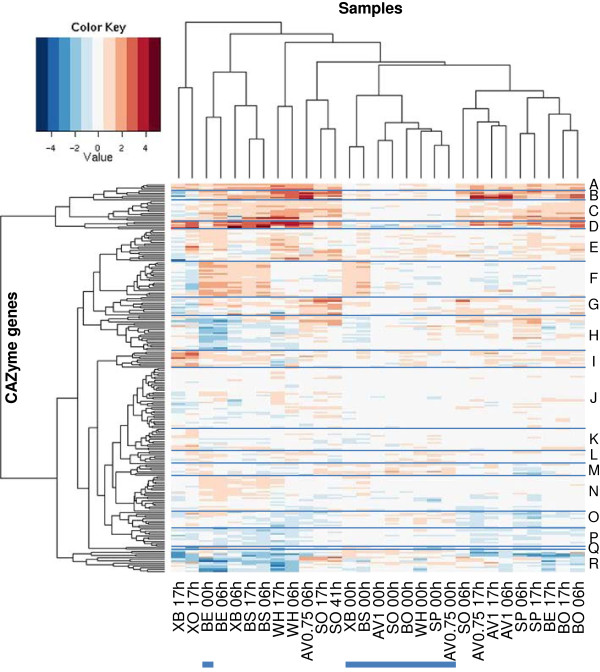
Heat map representing expression profiles of T. reesei CAZyme genes when the fungus was grown on different lignocellulose substrates. The fold change of the expression signal in the induced culture vs. the signal in the uninduced cultures at the same time point for each gene is represented by the color code (see the color key for the log2 scale fold changes). The data for each gene is represented as rows (for gene IDs from top to bottom see the Additional file 11, column a), and the samples collected at different time points of induction (0 h, 6 h, or 17 h) in the presence of the different substrates are shown as columns. BO, ground bagasse; BS, steam exploded bagasse; BE, enzymatically hydrolysed steam exploded bagasse; XO, oat spelt xylan; XB, birch xylan; AV1, 1% Avicel cellulose; AV0.75, 0.75% Avicel cellulose; WH, steam exploded wheat straw; SP, steam exploded spruce; SO, sophorose. The heat map was divided to 18 sub-branches (A-R) according to similarities in expression profiles. The zero time points are indicated by a blue line at the bottom.